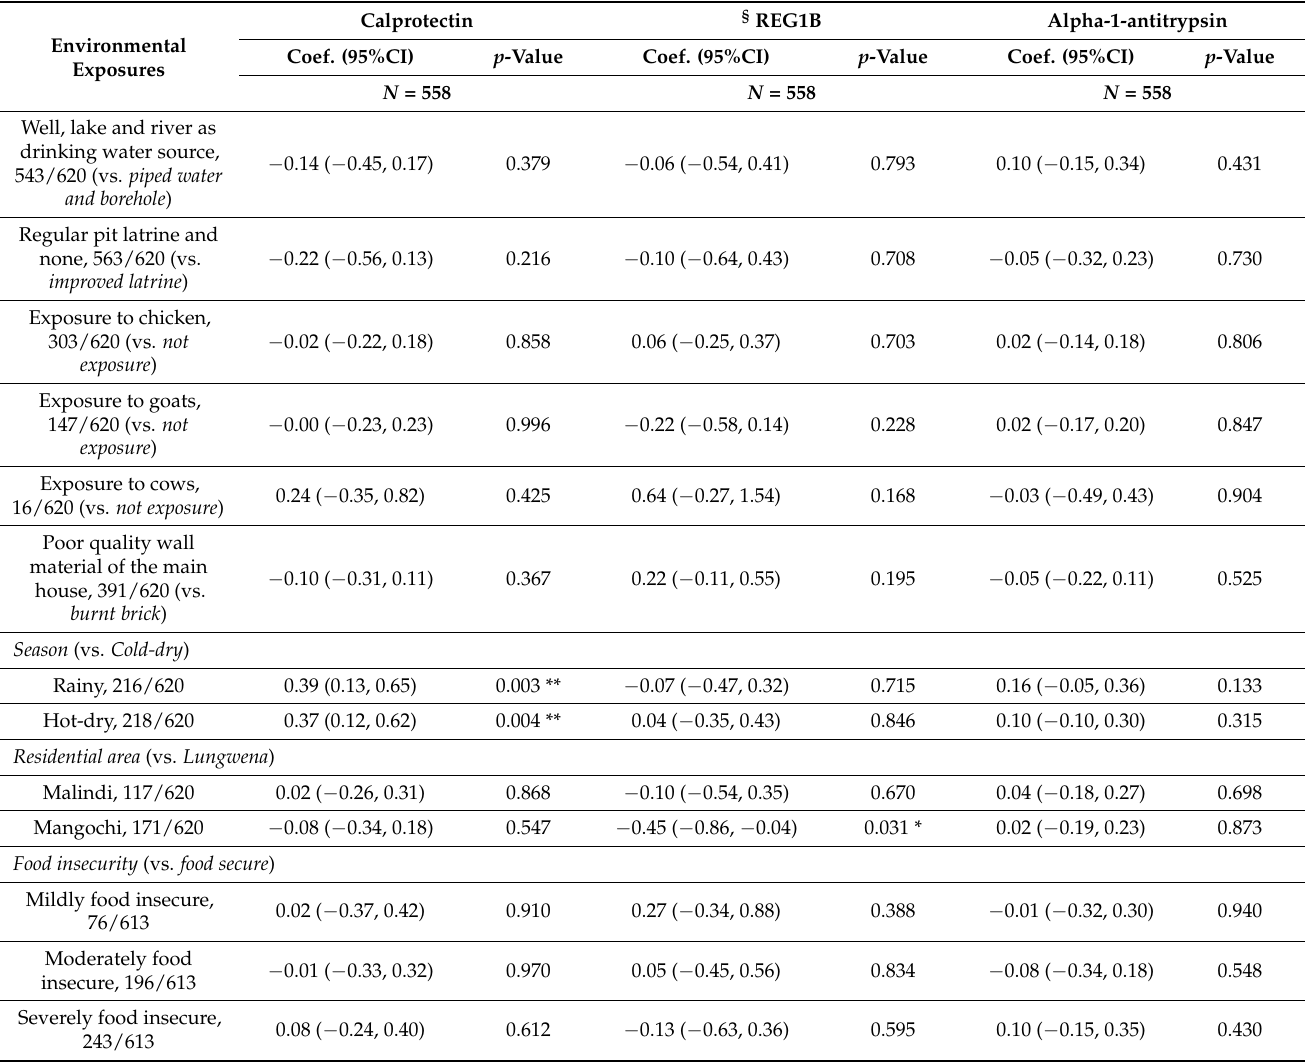
Table 3. Associations between environmental exposures and intestinal biomarkers in multivariable analysis †